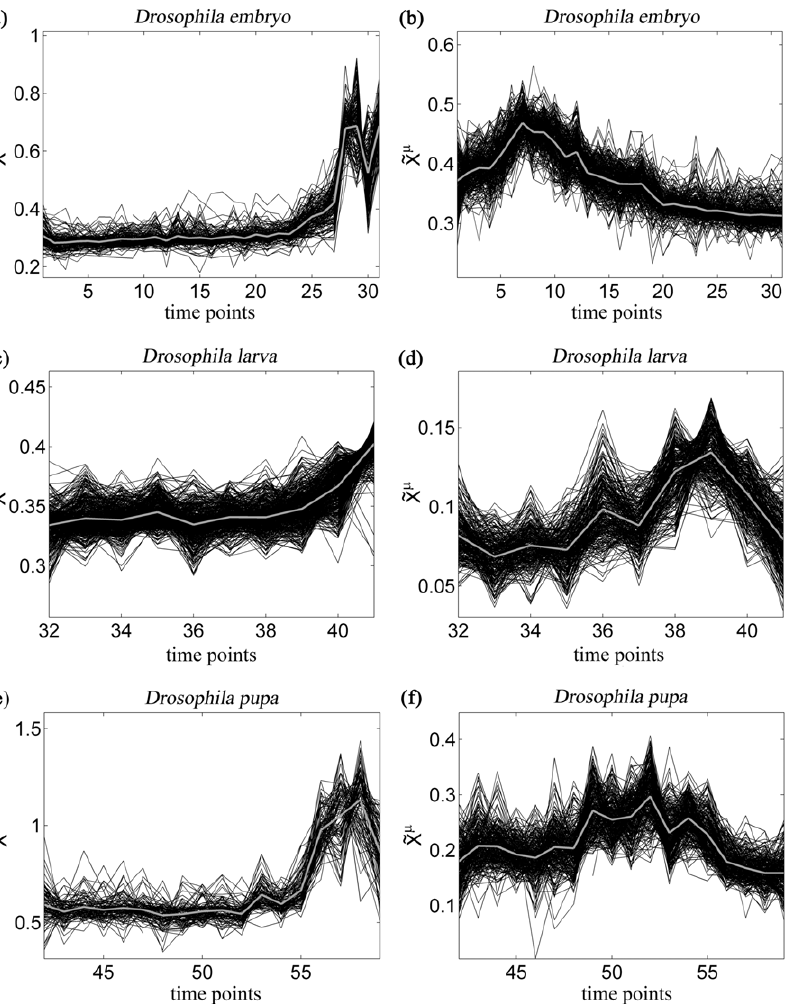
Figure 3. Examples of gene expression profiles ~ XX m ( t ) belonging to the same cluster, after suitable translation and dilatation to minimize the distance D R . The average profiles are indicated in gray. (a) Cluster of the embryonic stage, with 150 elements and , D intra . =0.41; (b) Cluster of the embryonic stage, with 294 elements and , D intra . =0.40; (c) Cluster of the larval stage, with 473 elements and , D intra . =0.26; (d) Cluster of the larval stage, with 271 elements and , D intra . =0.26; (e) Cluster of the pupal stage, with 97 elements and , D intra . =0.40; (f) Cluster of the pupal stage, with 256 elements and , D intra . =0.37.